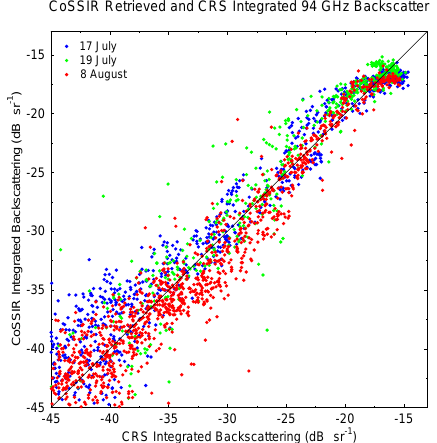
Fig. 13. Ice water path retrieved from CoSSIR on 19 July 2007 us- ing Monte Carlo integration and optimization (top panel). ln (IWP) error retrieved using Monte Carlo integration and the local Gaussian approximation (bottom panel).